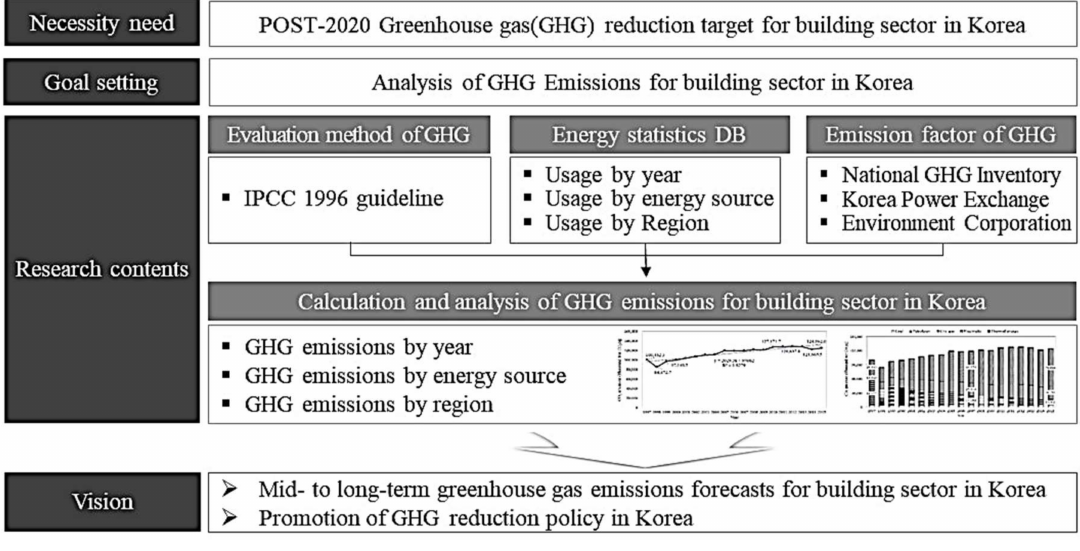
Figure 1. Research